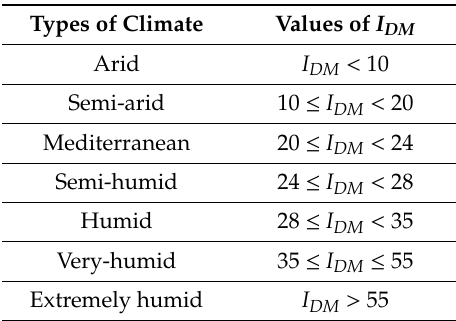
Table 1. The De Martonne Aridity Index (DMAI)